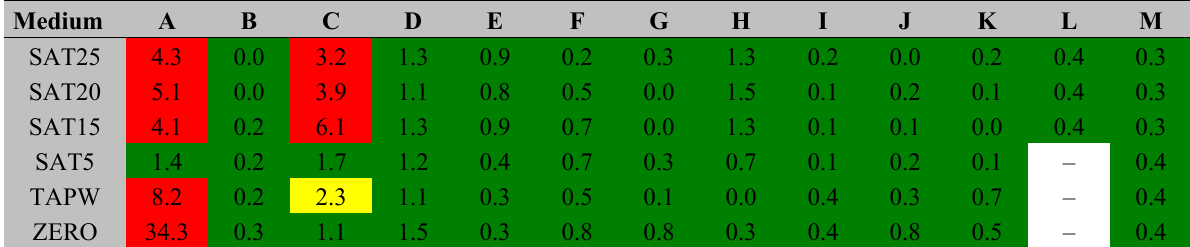
Table 9. The | z | values of the participants for DO measurement a .